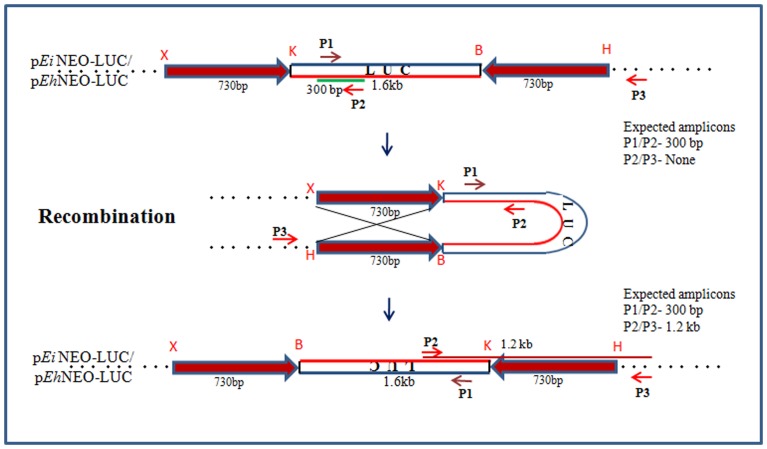
The inverted repeat substrate.A 730 bp segment was cloned in opposite orientation, flanking the 1.6E. histolytica vector pEhNEO-LUC and E. invadens vector pEiNEO-LUC. X: XhoI; K: KpnI; B: BamHI; H: HindIII. P1, P2, P3 are PCR primers (orientation indicated by arrows) used to measure inversion of the LUC sequence following recombination.